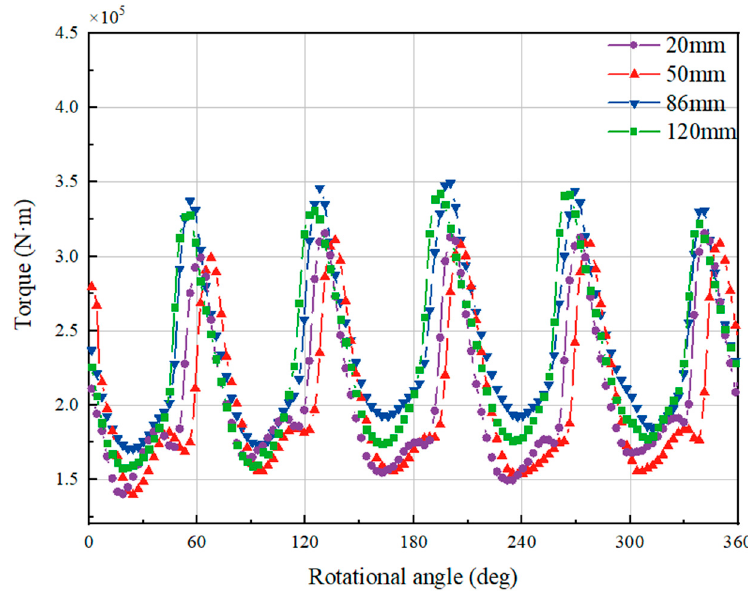
Figure 4. Torque variation of four different clearance scales in a cycle.